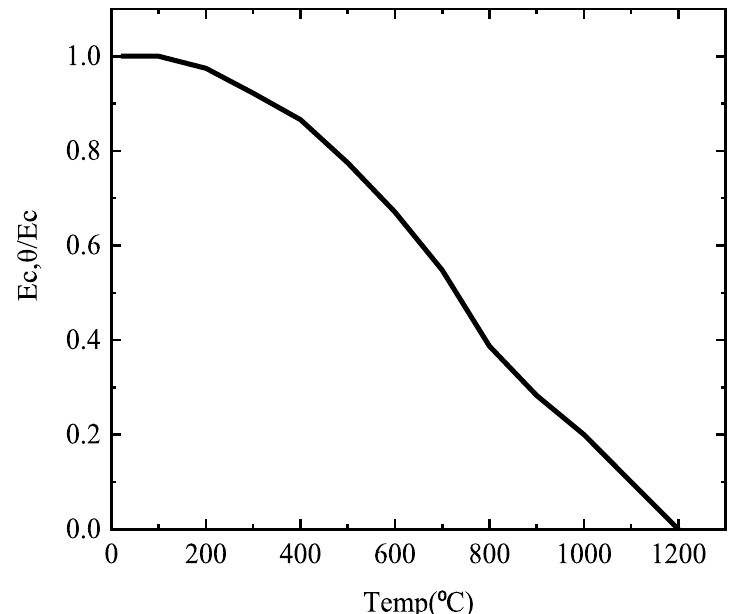
Fig. 19 Elasticity of concrete at elevated temperature